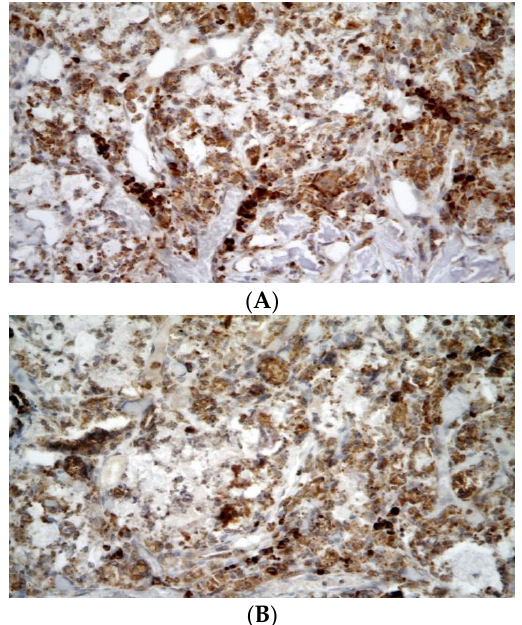
Figure 4 CD3-positive T-lymphocyte are recognized by brownish staining of cell membrane and cytoplasm. Their numbers were higher in group A (without application of CsA; ( A )) compared with group B (with application of CsA; ( B )) Immunohistochemistry, original magnification 400×.